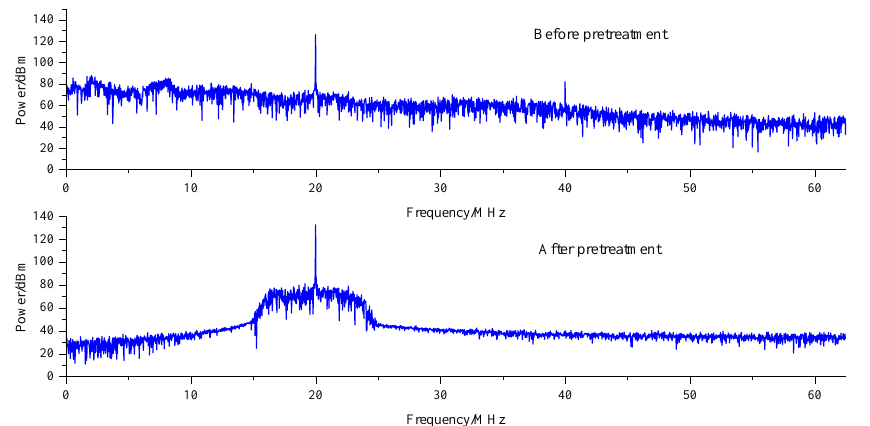
Figure 17. Spectrum of the measurement signal before filter and measurement signal after filter.